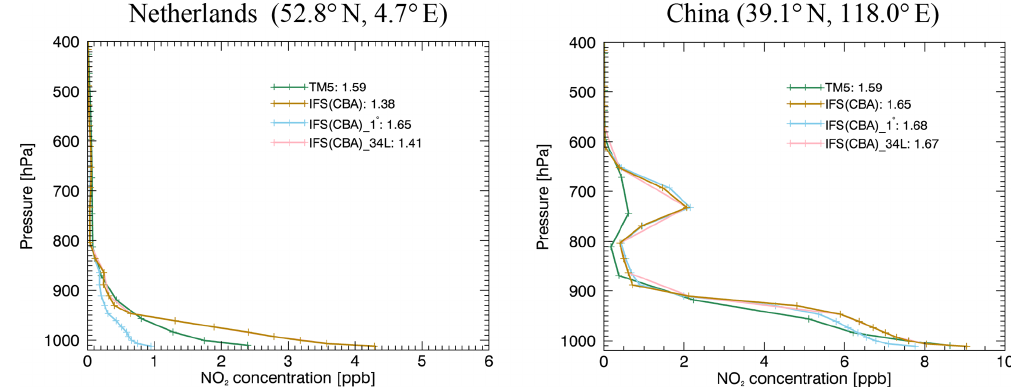
Figure 7. A priori NO 2 profiles from TM5-MP, IFS (CBA) (original resolution), and IFS (CBA) with different model resolutions over the Netherlands (52.8 ◦ N, 4.7 ◦ E) and China (39.1 ◦ N, 118.0 ◦ E) on 3 February 2010. The IFS (CBA) profiles for a 1 ◦ grid and for 34 layers are compared. The calculated clear-sky tropospheric AMF is given next to each label in the legends.